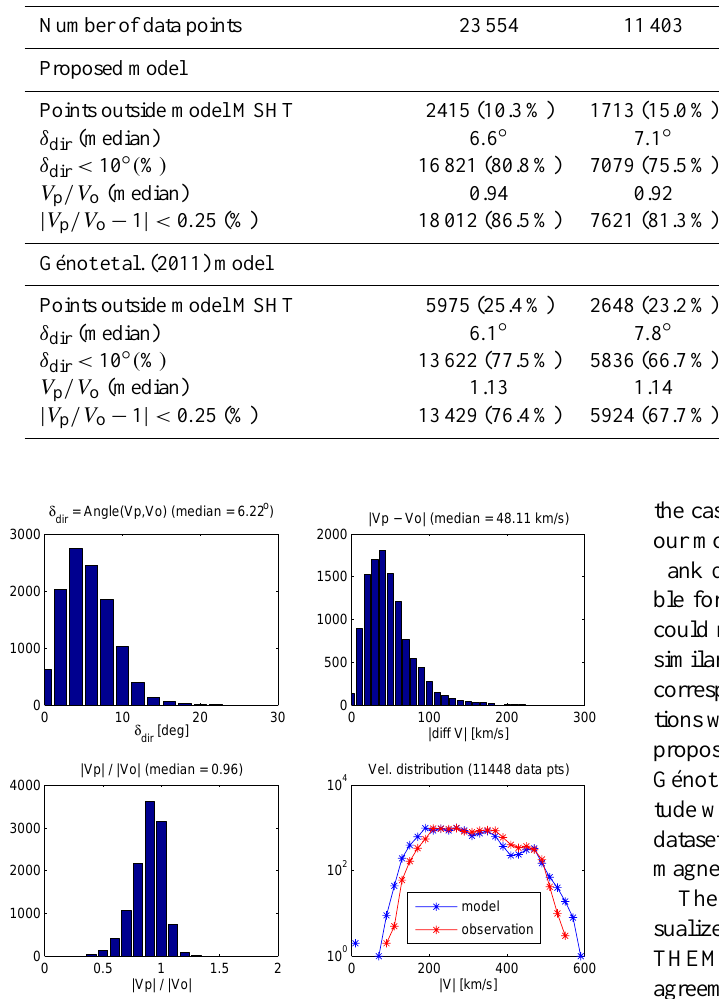
Table 1. Comparison of the performance of the proposed model with the model of G´enot et al. (2011) on the datasets. Here δ dir is the angle between the predicted velocity V p and observed flow velocity V o . The quality of velocity magnitude prediction is quantified by the V p /V o ratio. For both quantities the table shows a median value and number, absolute and relative, of data points where the prediction deviates by less than 10 ◦ in direction or by less than 25% in magnitude from the observation. We also give the number of points in each dataset which fall outside the model magnetosheath, and thus do not allow the application of the respective flow model. All Cluster Themis